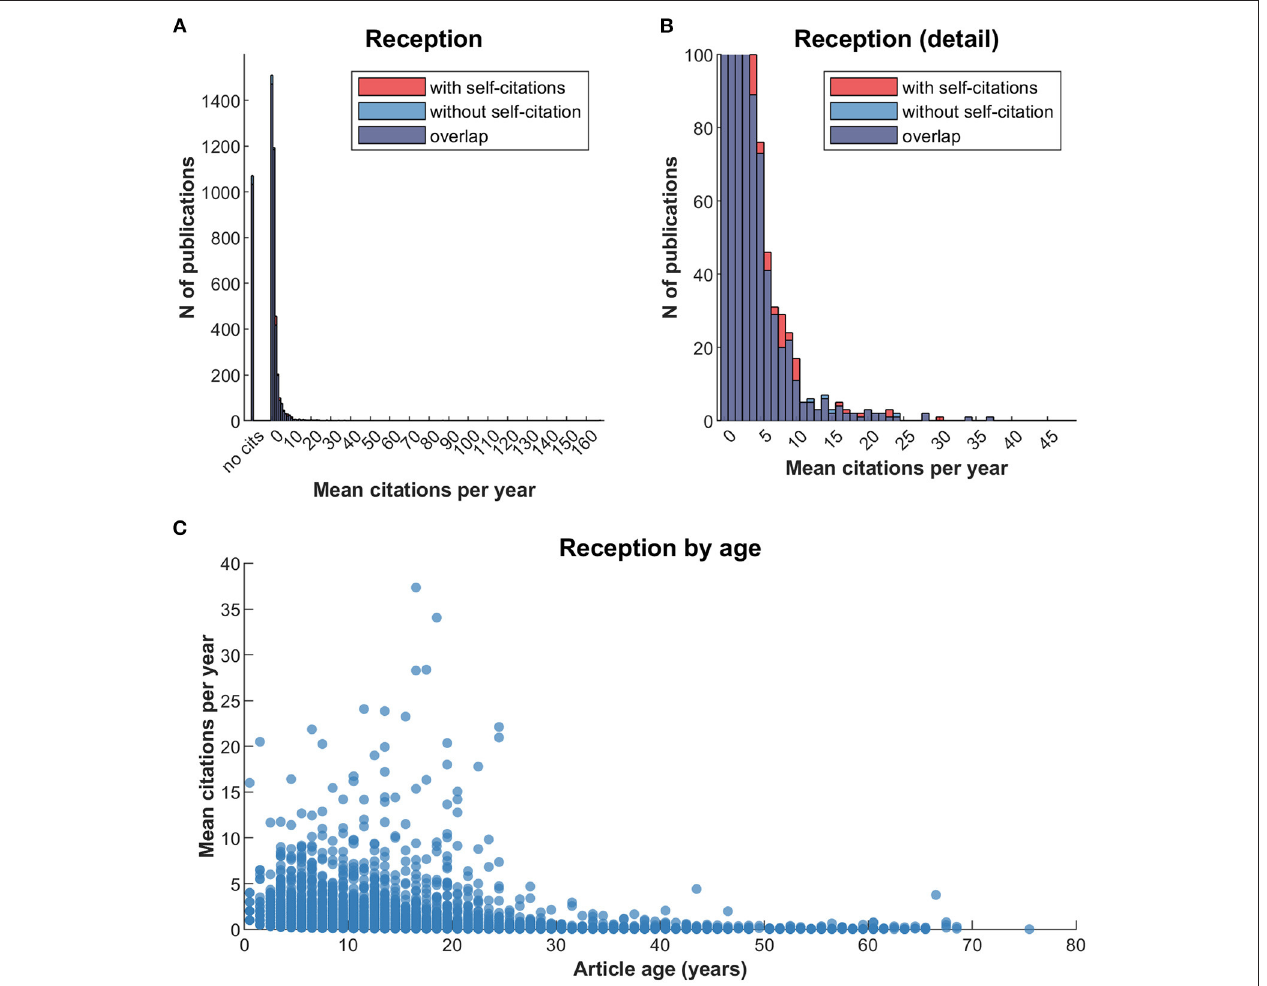
FIGURE 12 | Reception of JIPS articles over time. Note that this figure is limited in that article age and its dissemination are not unrelated, because very young articles may have had insufficient time for reception. (A) The number of publications binned by mean citations per year. (B) Same data as (A) , but with adjusted y axis to see details of the distribution more clearly. (C) Mean citations per year, by article age. For illustration purposes, axes were set to exclude two very high-performing articles (PMID 24141714 with age 57 and 87.4 mean citations; PMID 8721797 with age 24 and 173.3 mean